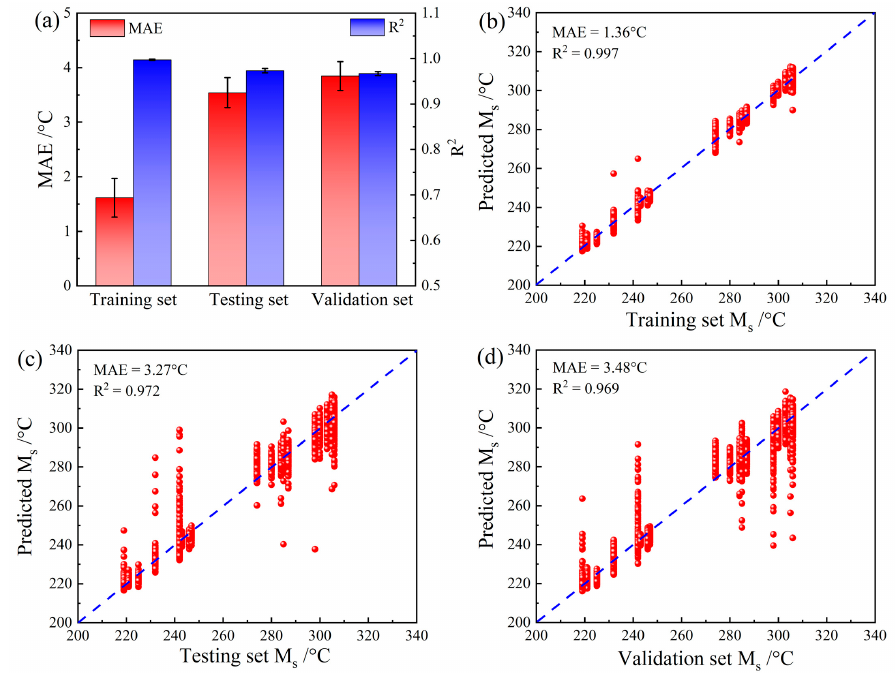
Figure 8. Comparison with traditional CNN methods using only microstructure image input: ( a ) comparison of MAEs and R 2 values, ( b ) results of the training set, ( c ) results of the testing set, and ( d ) results of the validation set.